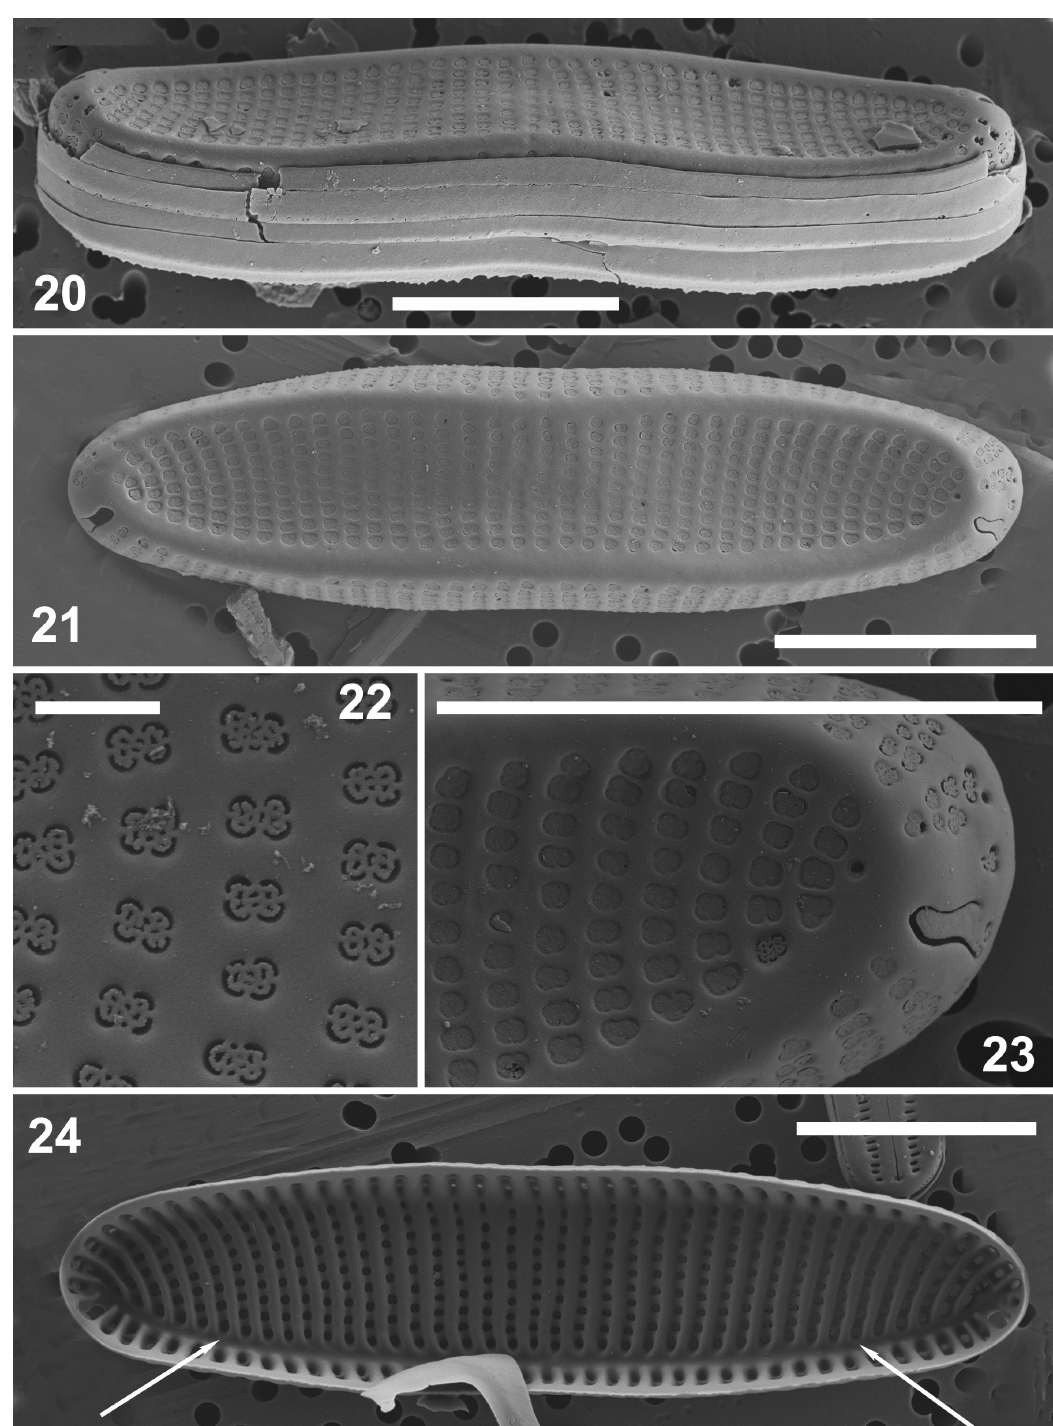
Figs 20–24. Achnanthes kohleriana Kopalová, Zidarova & Van de Vijver sp. nov. Scanning electron micrographs of the type population from Deception Island (South Shetland Islands, Antarctica). 20 . SEM girdle view of an entire frustule. 21 . SEM external view of a raphe valve. 22 . SEM external detail of the areolae with the typical cribrate structure. 23 . SEM external detail of the apex with the typical terminal orbiculus. 24 . SEM internal view of an entire rapheless valve. Arrows show the rapheless sternum. Scale bars represent 10 µm for Figs 20, 21 & 24, 1 µm for Fig. 22 and 5 µm for Fig.